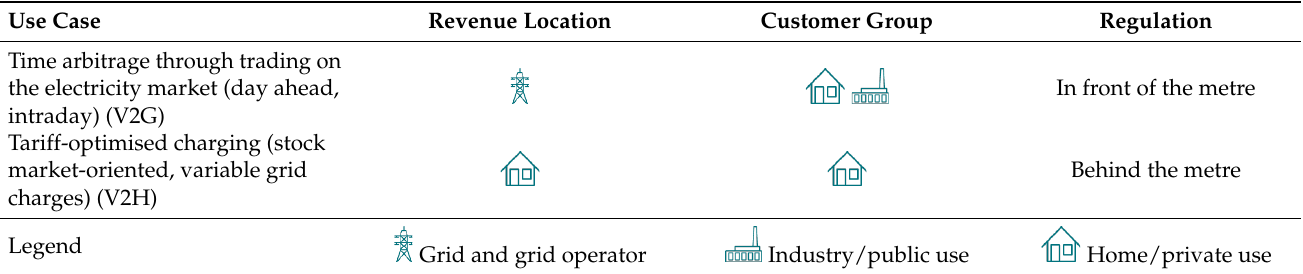
Table 1. Use cases of smart charging via price incentives ([7], Source: BDL project).